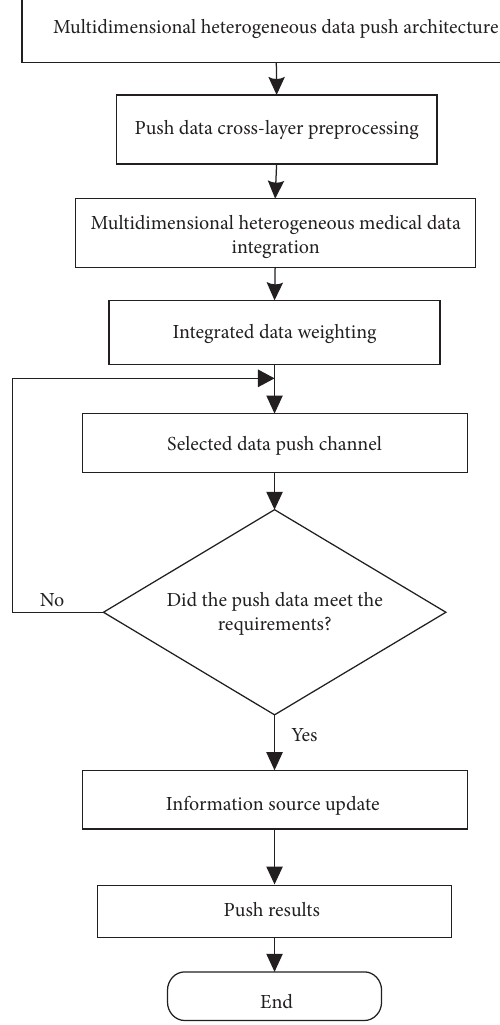
Figure 6: Multidimensional heterogeneous medical data push management